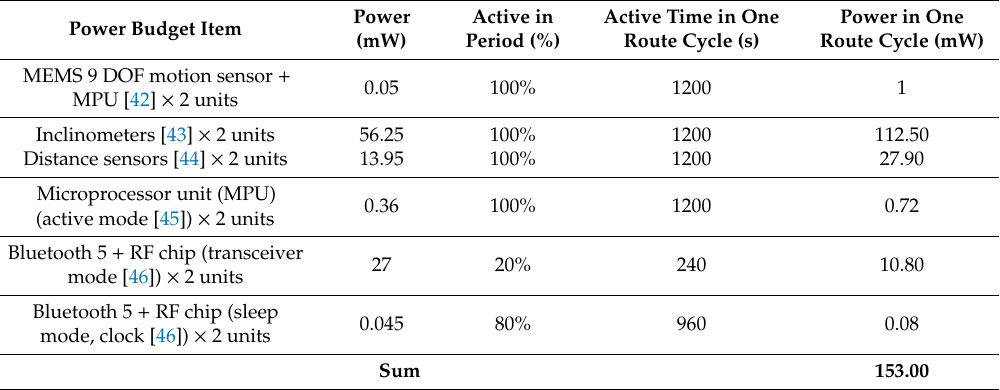
Table 7. Estimated power budget of the sensor platform with the application of the route assumption of this vehicle.